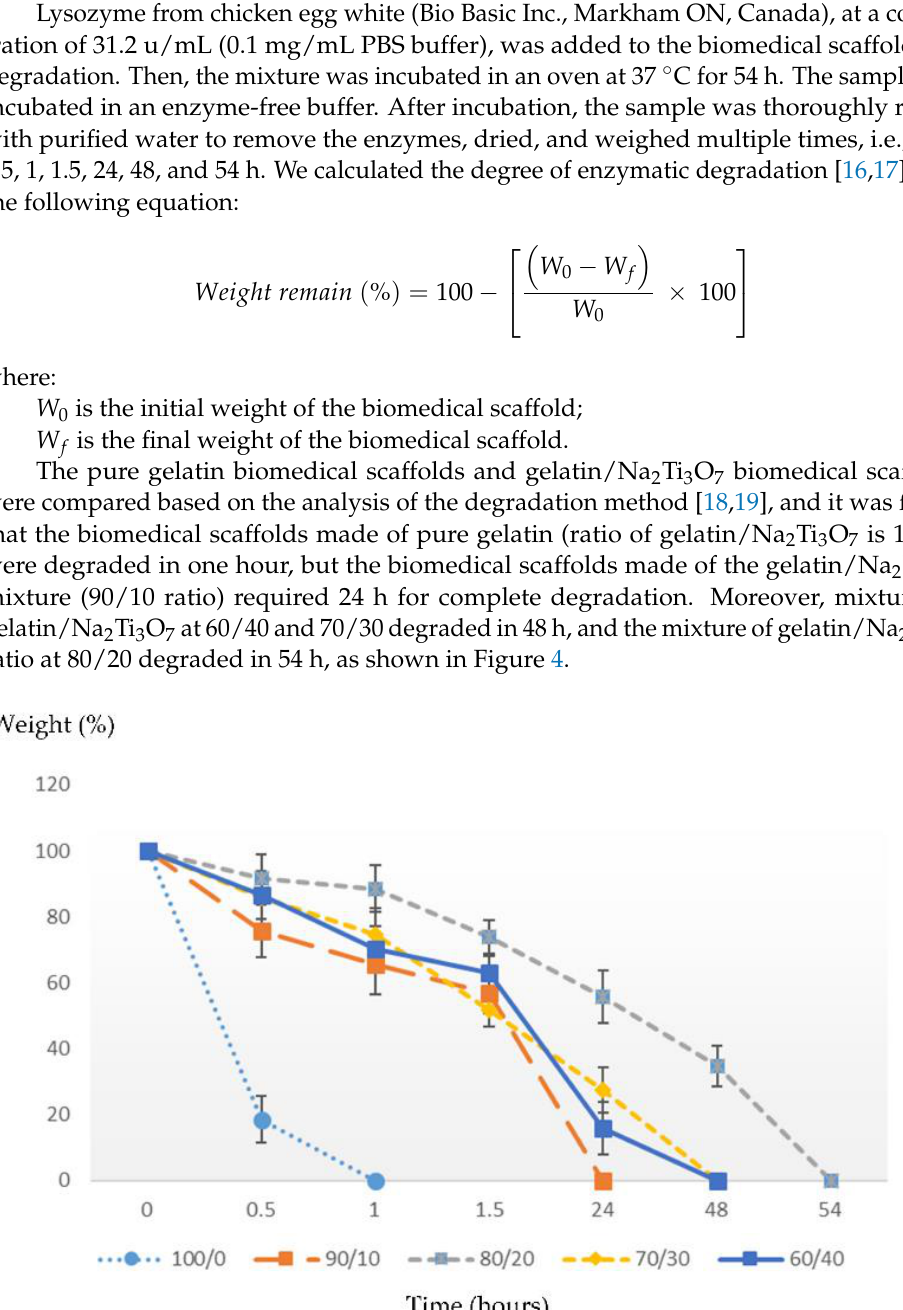
6 of 10 Figure 3. Multiple response prediction.